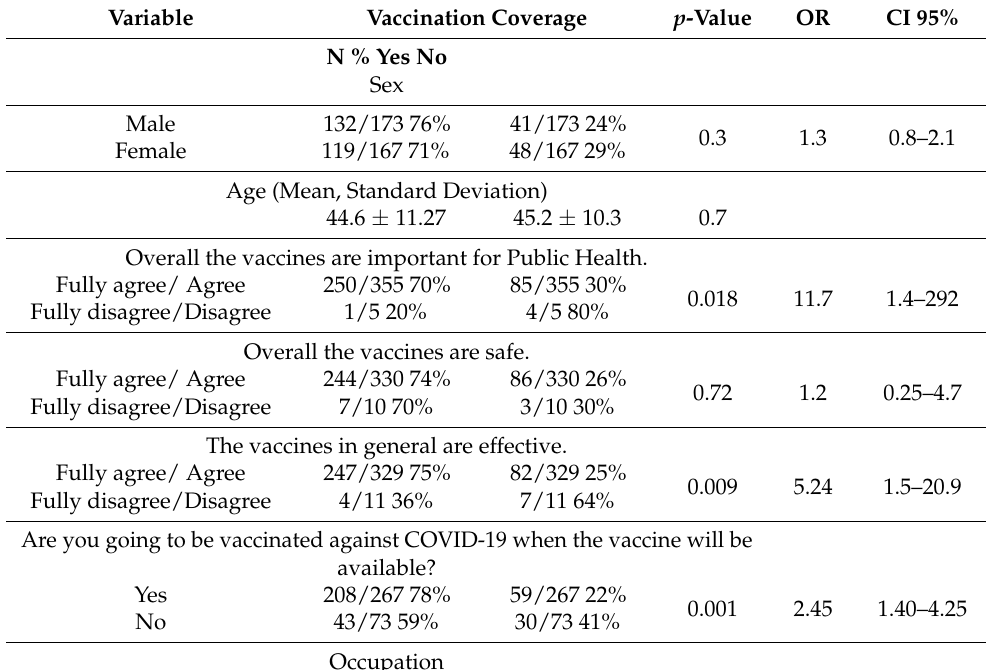
Table 1. Univariate analysis of influenza vaccination coverage